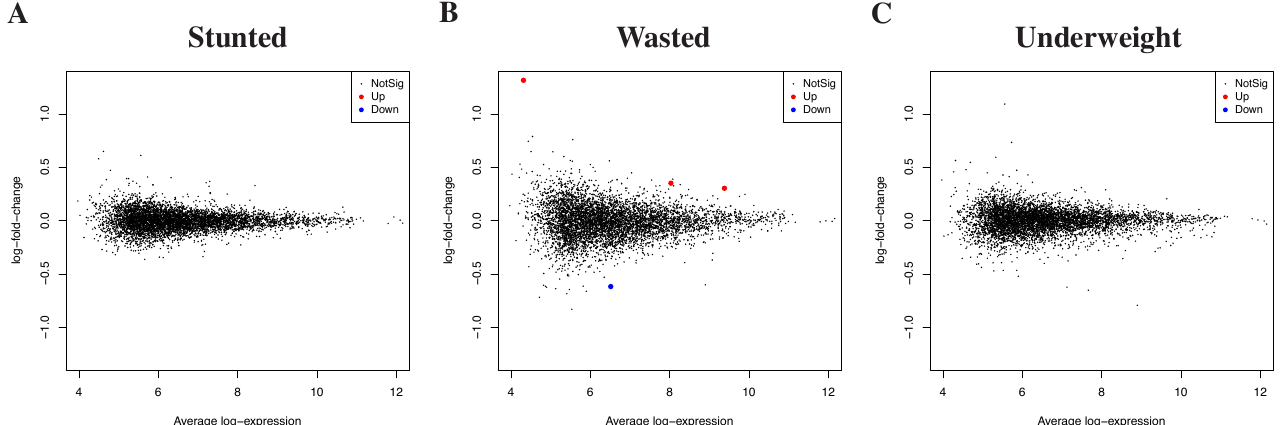
Figure 3. Differential gene expression at endline by growth outcomes. RNA sequencing analysis of whole blood from participants at endline, showing associations between gene expression and ( A ) stunting (length-for-age z-score < − 2), ( B ) wasting (weight-for-length z-score < − 2) and ( C ) underweight (weight-for-age z-score < − 2). Red = gene significantly upregulated. Blue = gene significantly